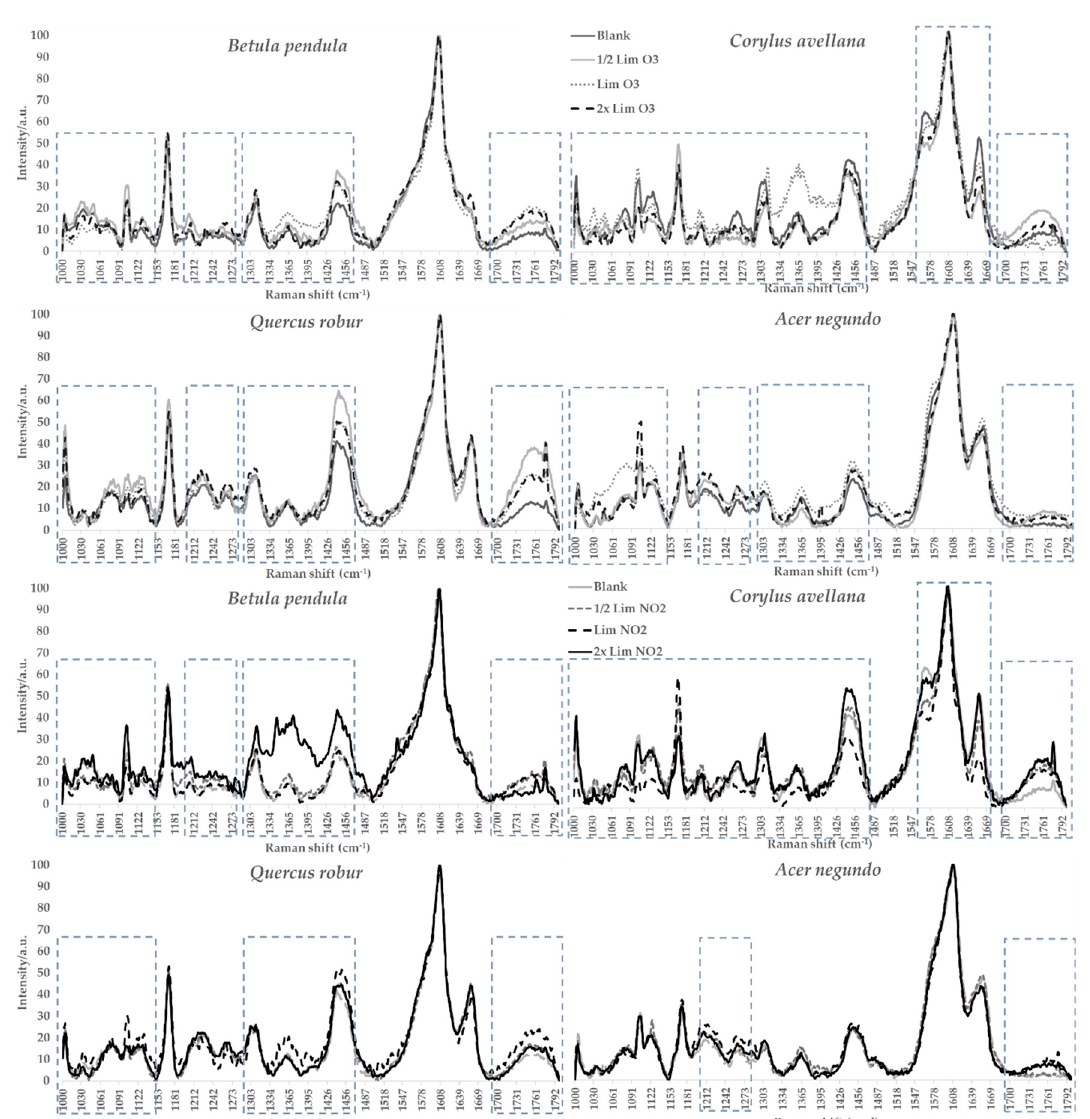
Figure 2. Average Raman spectra of A. negundo, B. pendula, C. avellana and Q. robur pollen, exposed for 6 h to O 3 (upper figure) and NO 2 at concentrations corresponding to half the limit (1/2), the limit (Lim) and the double limit (2 × Lim) values for the protection of vegetation according to the EU Directive 2008/50/EC on ambient air quality and cleaner air for Europe. The grey squares highlight the regions where visible changes occur.